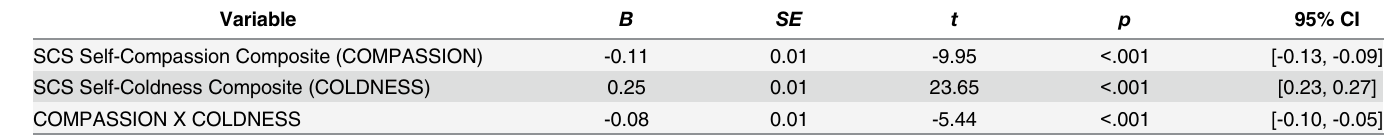
Table 4. Moderation of the Relationship Between Self-Coldness and PHQ-9 by Self-Compassion (n = 2,311)